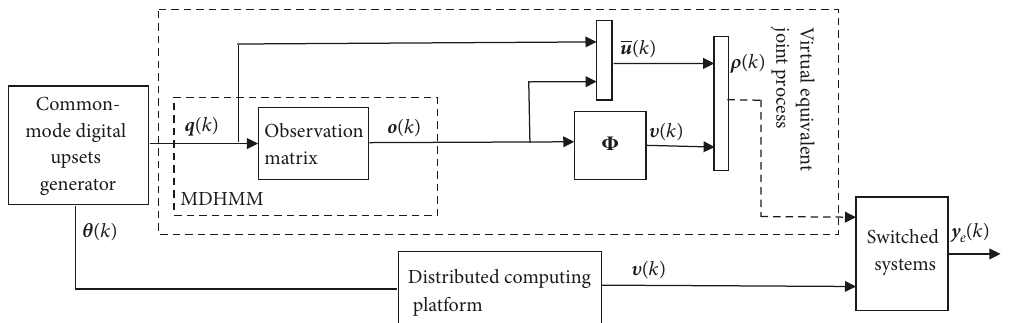
Figure 5: Joint process conceptual schematic over the distributed configuration under digital upsets modeled by MDHMM.